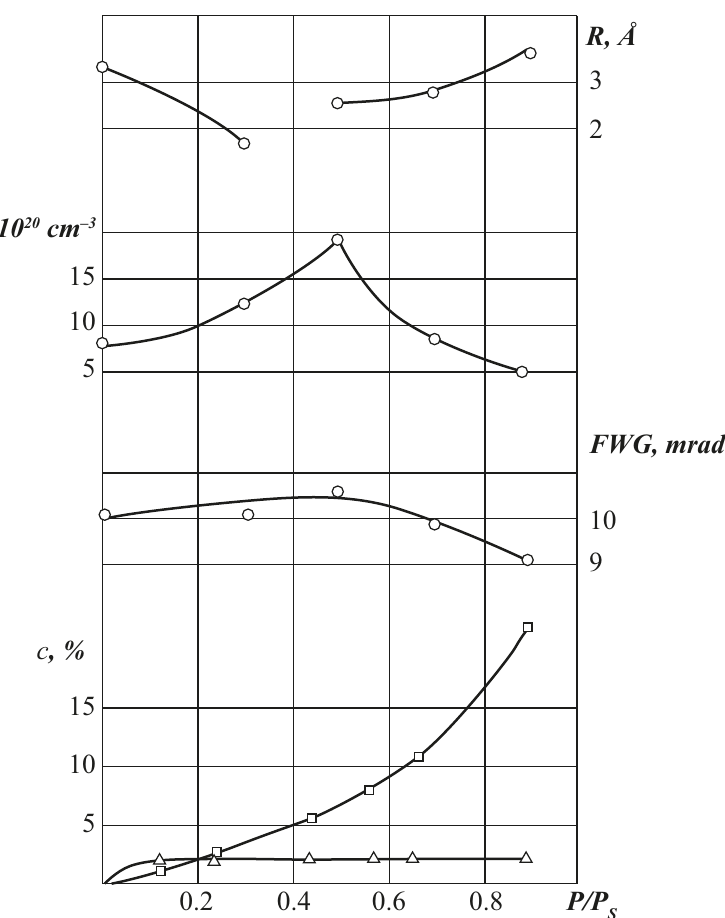
Figure 7. Changes in the parameters of free volume ( R, n ν ), matrix (FWG), and sorption characteristics of CA (SD = 1.21) at 20 °C as the sample is saturated with water. ∆ —Langmuir component, □ —Flory–Huggins isotherm.